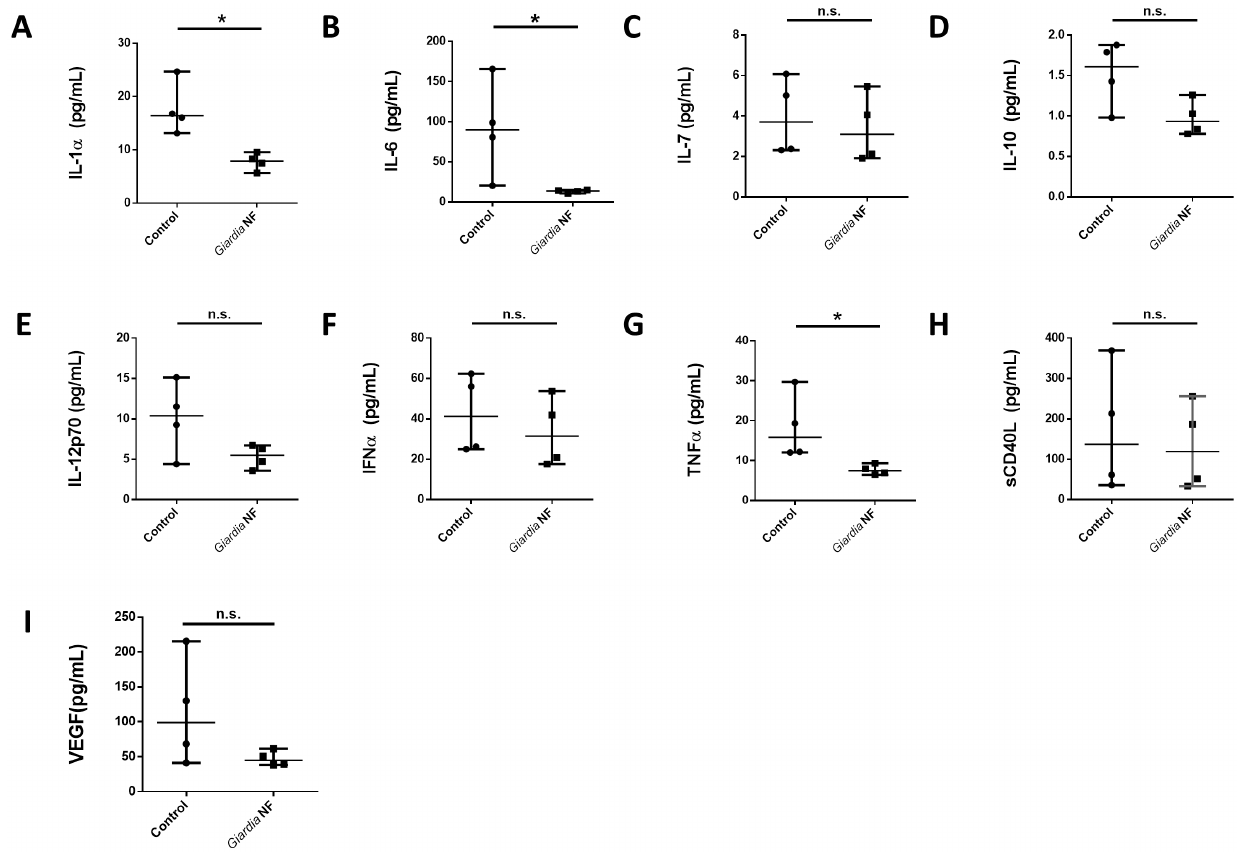
Figure 11. Giardia NF trophozoites attenuate the expression of certain pro-inflammatory mediators assessed in colonic mucosal biopsy tissue homogenates. Human descending colon mucosal biopsy tissues obtained from areas of active inflammation from patients with active Crohn’s disease (CD) were incubated with 5.0 6 10 6 Giardia NF trophozoites for 6 hours. Tissue homogenate levels of (A) IL-1 a , (B) IL-6, (C) IL-7, (D) IL-10, (E) IL-12p70, (F) IFN a , (G) TNF a , (H) sCD40L, and (I) VEGF were determined via a bead-based cytokine assay. All data are representative of three independent experiments (n=4–6/group) and represented as median with the range. * p , 0.05.